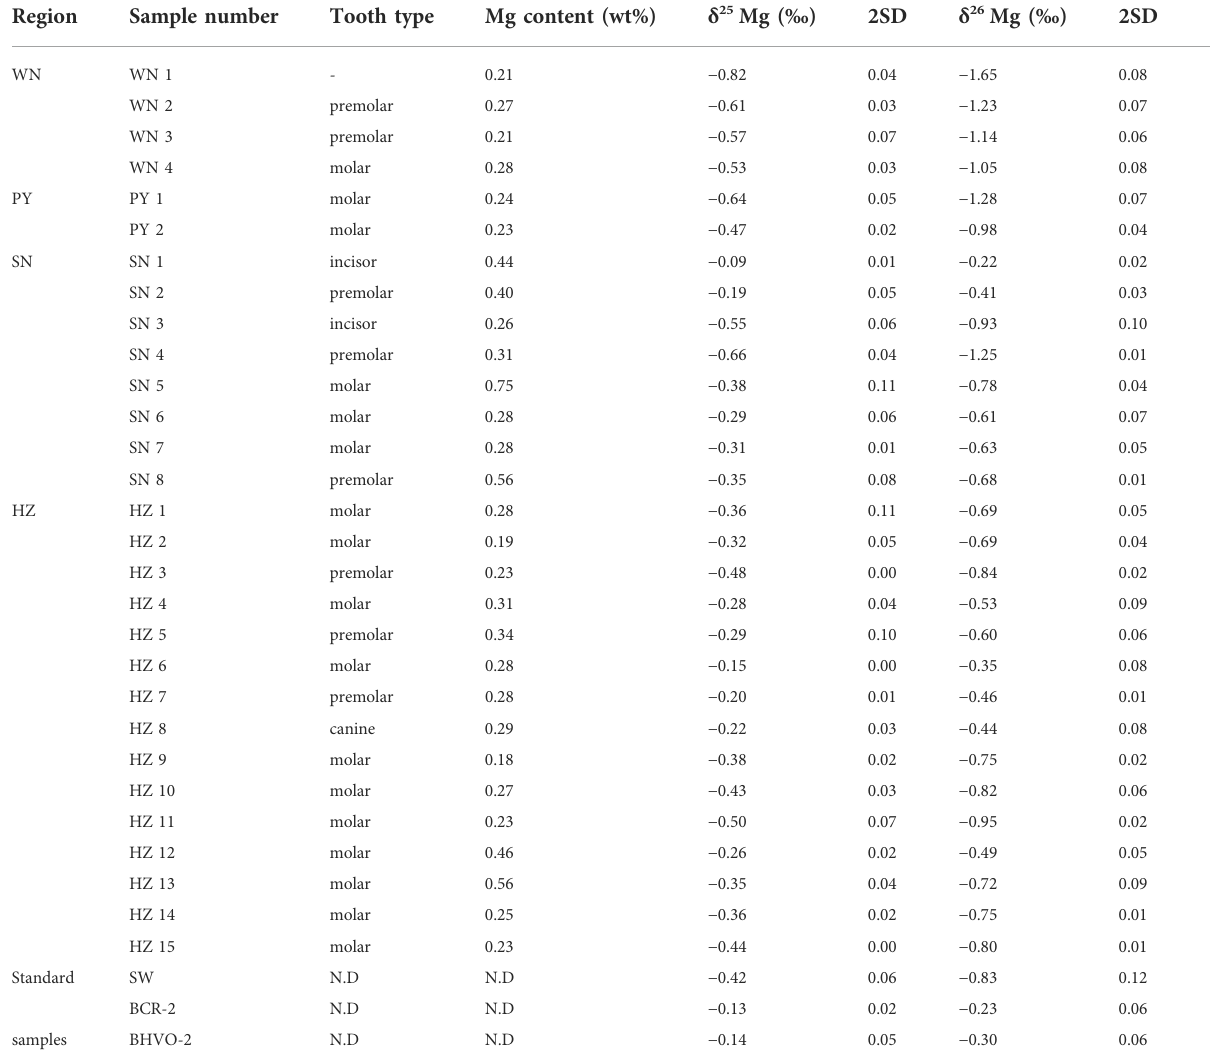
TABLE 1 Magnesium elemental contents and isotopic compositions of modern human teeth enamel from WN (Weinan), PY (Puyang), SN (Southern Shaanxi regions) and HZ (Hangzhou).